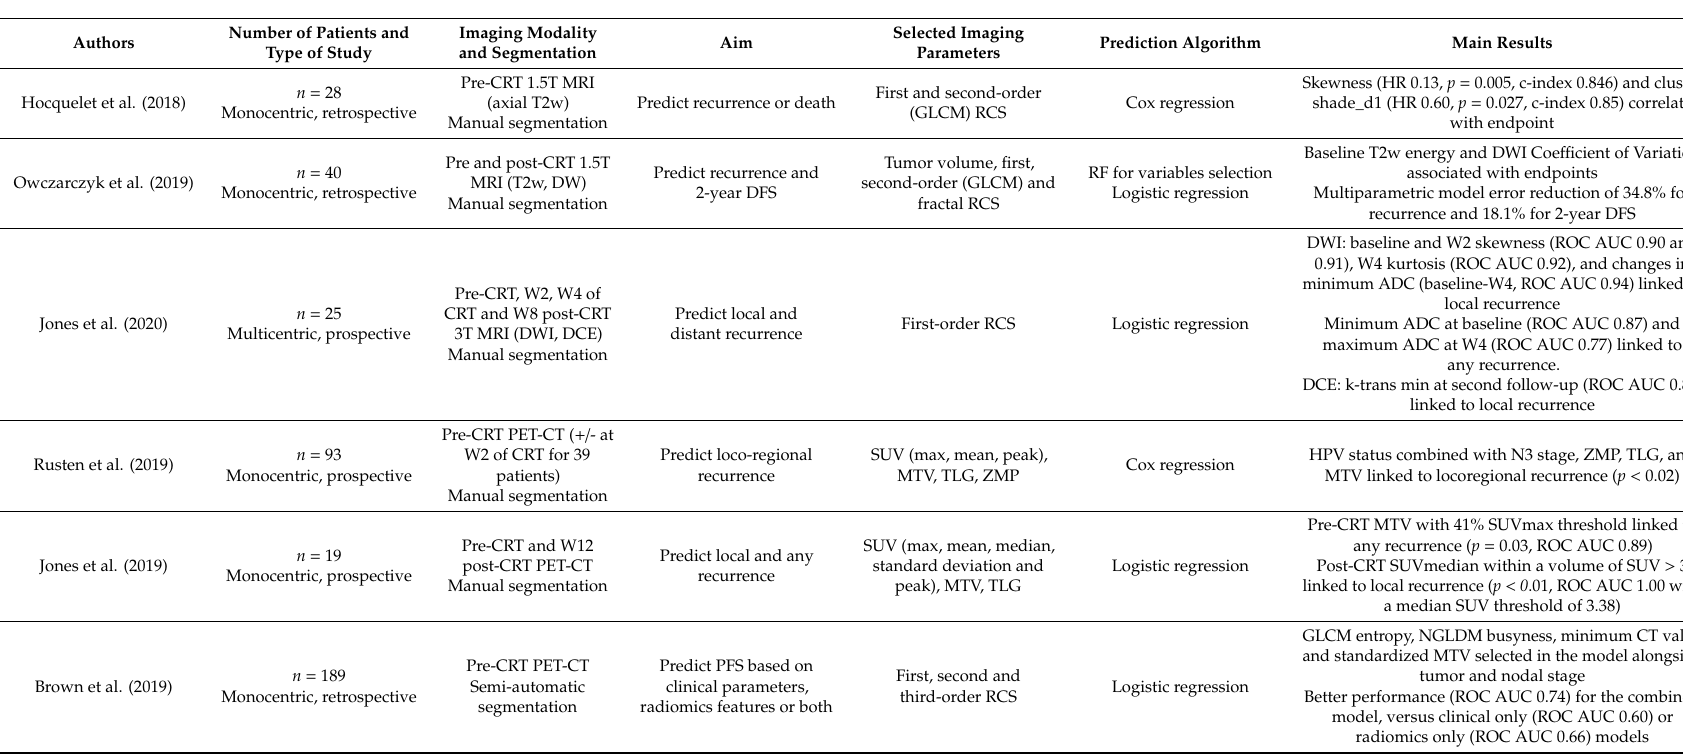
Table 1. Summary of studies that have explored imaging parameters and radiomics for prediction of response to chemo-radiotherapy in anal squamous cell